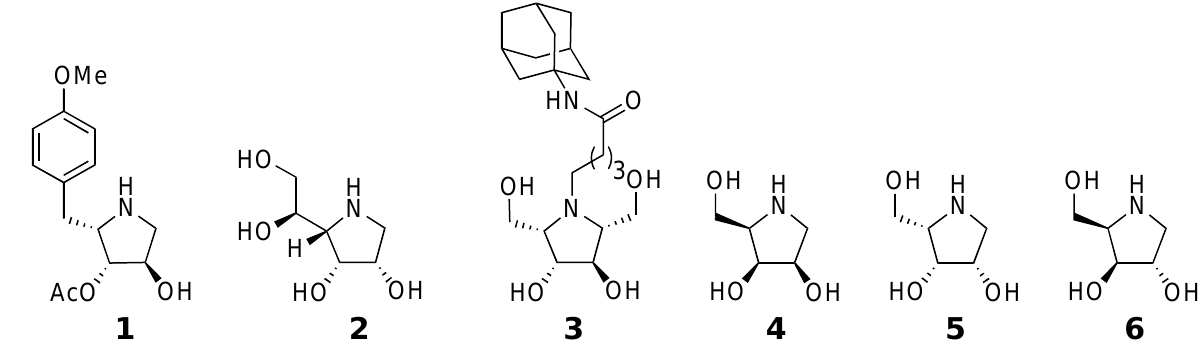
Figure 1. Representative pyrrolidines containing the 3,4- cis substituted